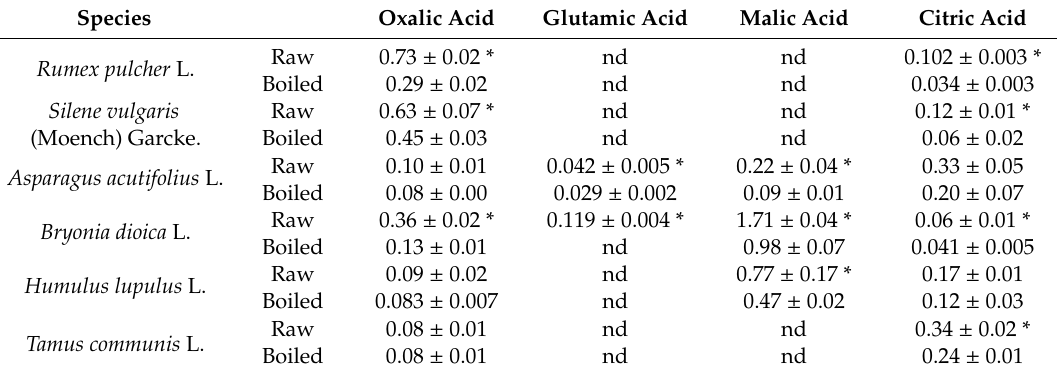
Table 5. Vitamins B 9 (folates) and C in raw and boiled wild vegetables (mg / 100 g fresh weight). Total Total Folates AA DHAA Vitamin C % PRI % PRI Species (mg / 100 g) (mg / 100 g) (mg / 100 g) (mg / 100 g) Rumex pulcher L. Silene vulgaris (Moench) Garcke. Asparagus acutifolius L. Bryonia dioica L. Humulus lupulus L. Tamus communis L. AA = ascorbic acid; DHAA = dehydroascorbic acid. nd = non detected; PRI = population reference intake. Data expressed as mean ± standard deviation ( n − 1). n = 3. * Statistically significant di ff erences ( p < 0.05), between raw and boiled samples. Table 6. Organic acids in raw and boiled wild vegetables (g / 100 g fresh weight). Species Oxalic Acid Rumex pulcher L. Silene vulgaris Raw (Moench) Garcke. Asparagus acutifolius L. Bryonia dioica L. Humulus lupulus L. Tamus communis